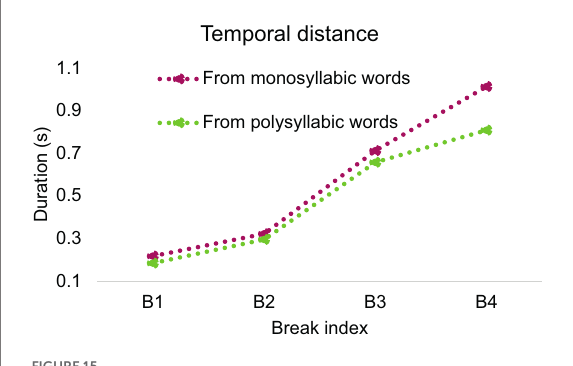
FIGURE 15 Temporal distance as a function of break index in Mandarin.